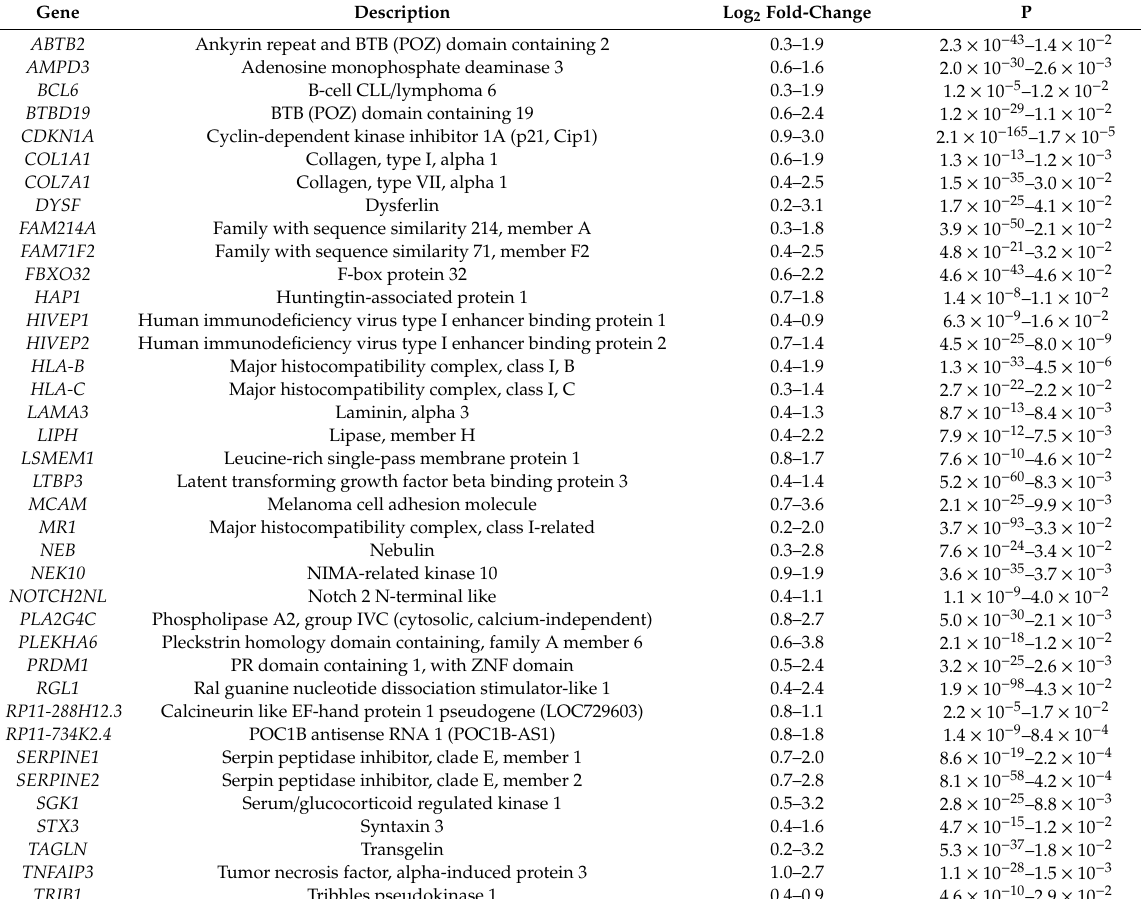
Table 2. Genes for which expression was upregulated by radiation in all cell lines a